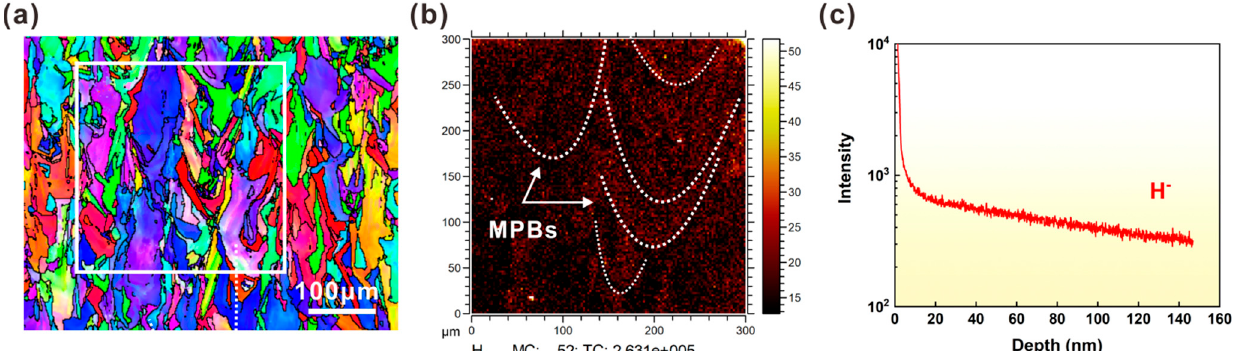
Figure 9. ( a , b ) EBSD and SIMS maps of the H-charging sample. The white square in ( a ) indicates the area of the SIMS map. ( c ) SIMS depth profiles of H − in the H-charging sample show a rapid decrease in the tread with the distance from the sample surface.